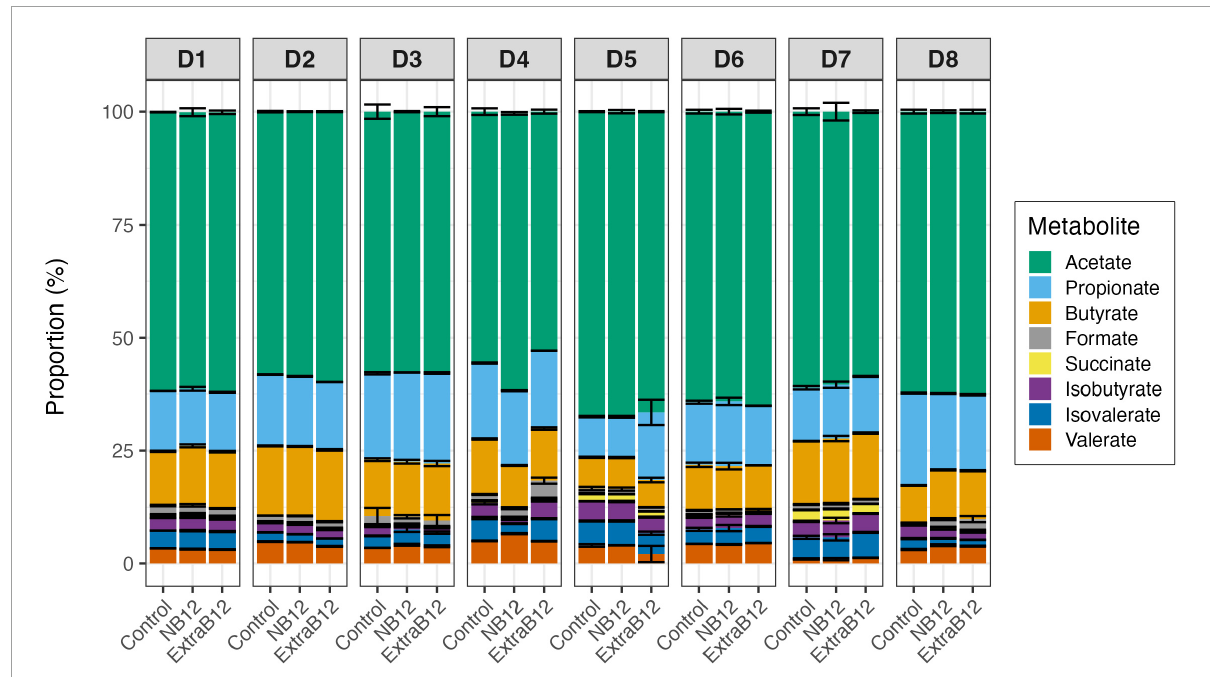
FIGURE6 Proportion of metabolites produced after 24 h batch fermentations of eight fecal donor microbiota (D1 to D8) in three treatments conditions (Control, NB12, and ExtraB12). Proportion of acetate, propionate, butyrate, formate, lactate, succinate, isobutyrate, isovalerate, and valerate with respect to the total metabolites produced after fermentation. Average and standard deviation of three replicates. Lactate was below the limit of quantification (1 mM) for all donors